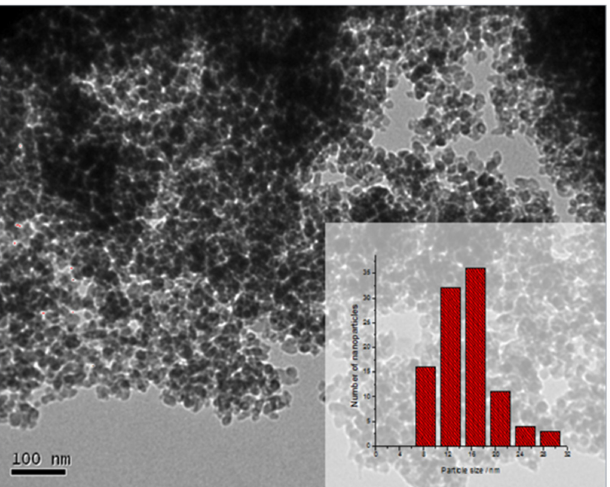
Figure 4. TEM image of the pyrolytic product from VCl 3 • chitosan (1:5) and their histogram (inset) adapted from reference